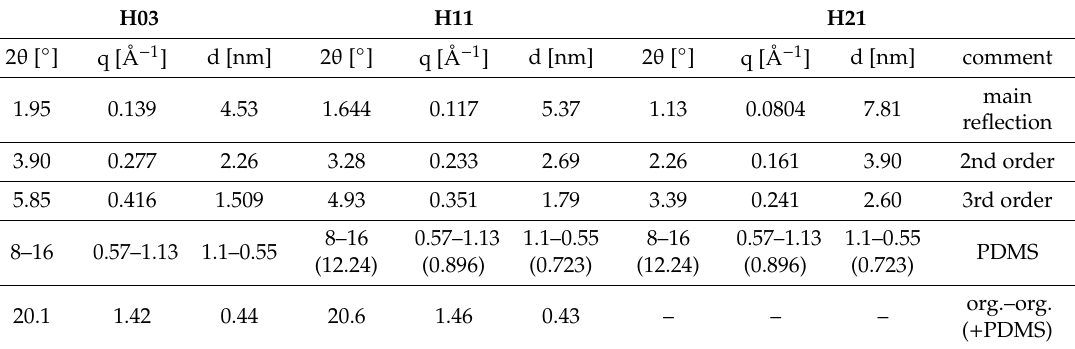
Table 3. X-ray di ff raction results. PDMS–BAFKU 2 copolymers: Interference maxima and the corresponding characteristic